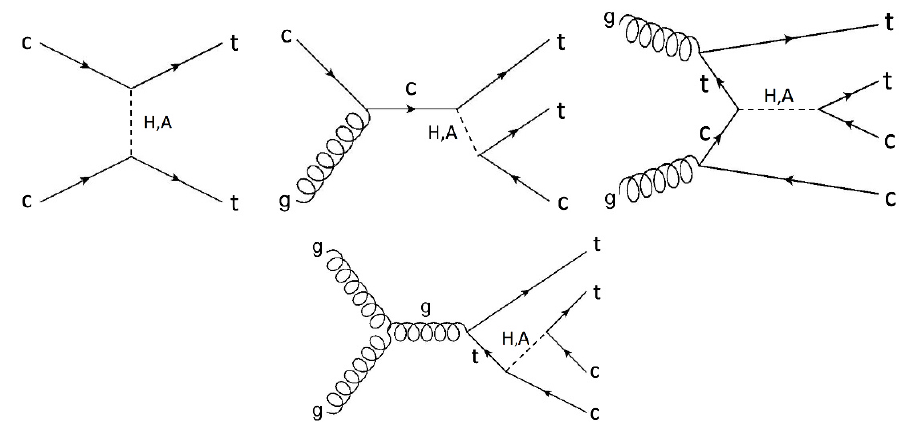
Figure 11 . Feynman diagrams relevant to the same-sign top